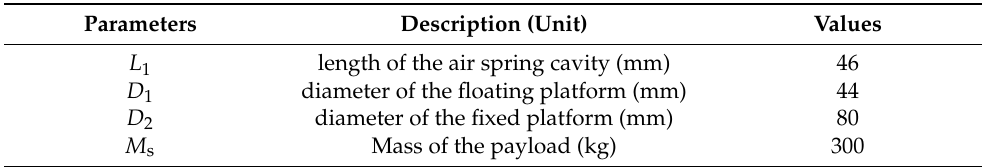
Table 2. Initial state of the simulation.